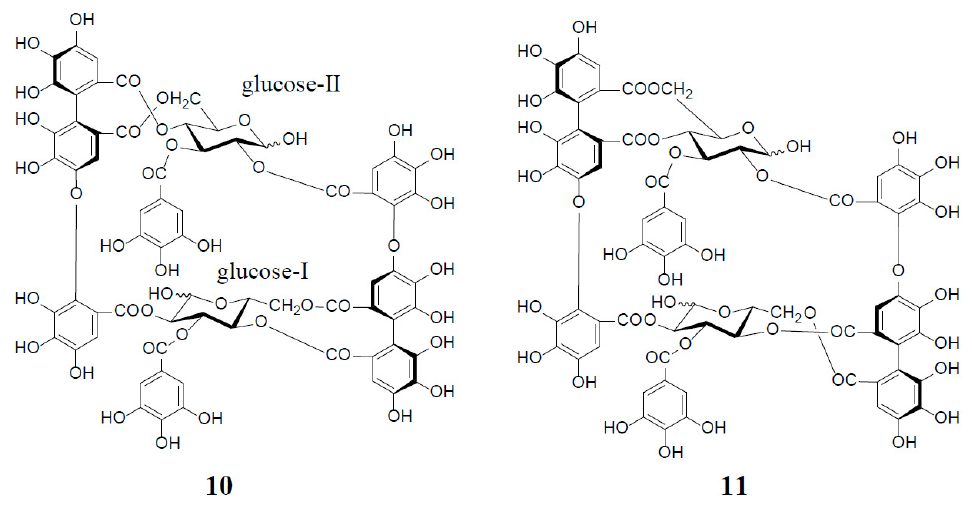
Figure 2. Structures of oenotheins D ( 10 ) and F ( 11 ).